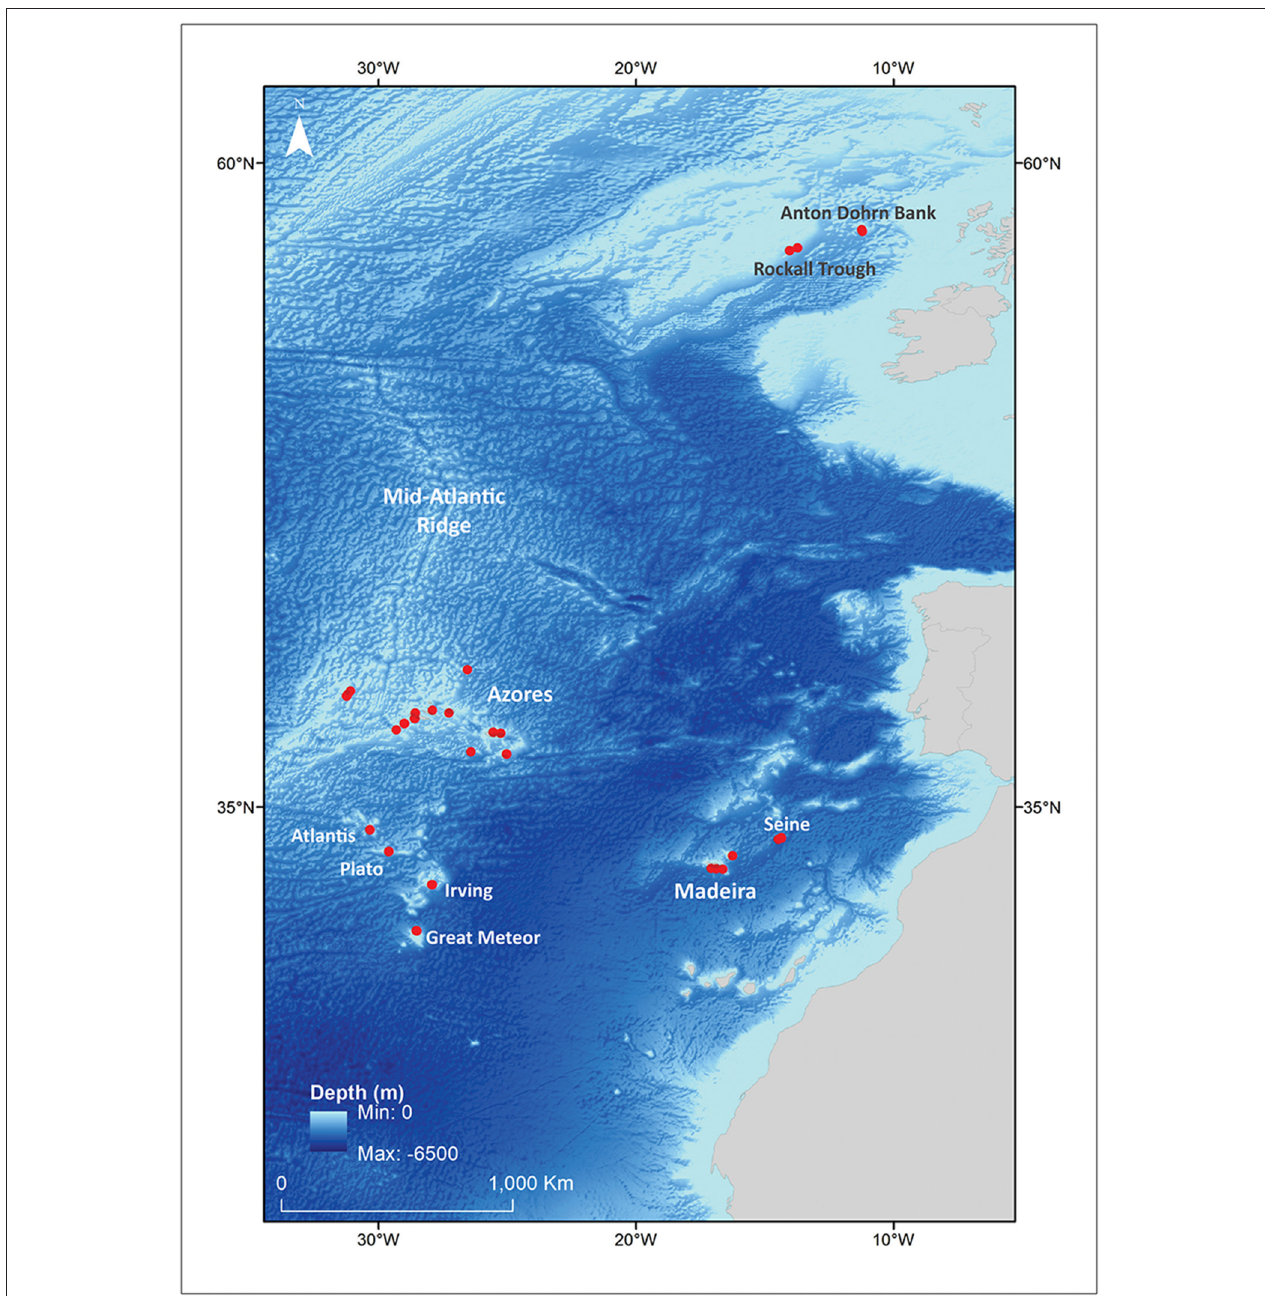
FIGURE 1 | Sampling areas for Deania species in the NE Atlantic (see also Table 1 ) used in the molecular and denticle analyses.